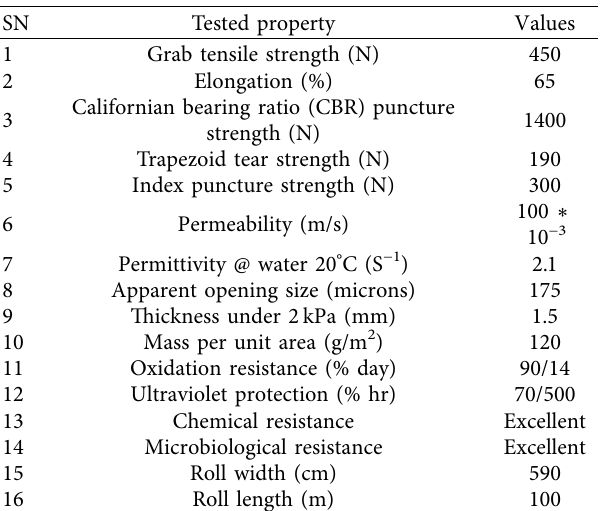
Figure 3: Particle size distribution of the clay and cinder gravel used. Table 4: Some physical and mechanical properties of geotextile